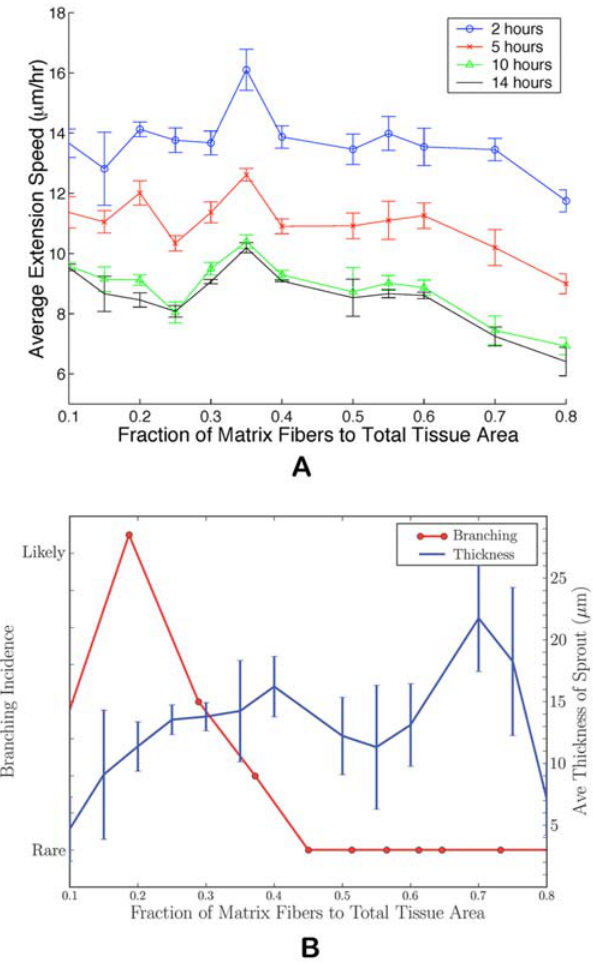
Figure 2. Matrix density influences sprout velocity and branching. (A) Dependence of average sprout extension speed on the density of the extracellular matrix. The model predicts that average extension speeds are maximal in the fiber fraction range r ~ 0 : 3 { 0 : 4 . Above r ~ 0 : 6 , extension speeds are significantly reduced and for r v 0 : 1 and r w 0 : 8 normal angiogenesis is interrupted suggesting that modulating matrix density may be an effective anti-angiogenesis therapy. (B) Quantification of morphological properties of the sprout showing sprout thicknesses within normal physiological ranges but dependent on matrix density and a distinct range of fiber density conductive to branching.